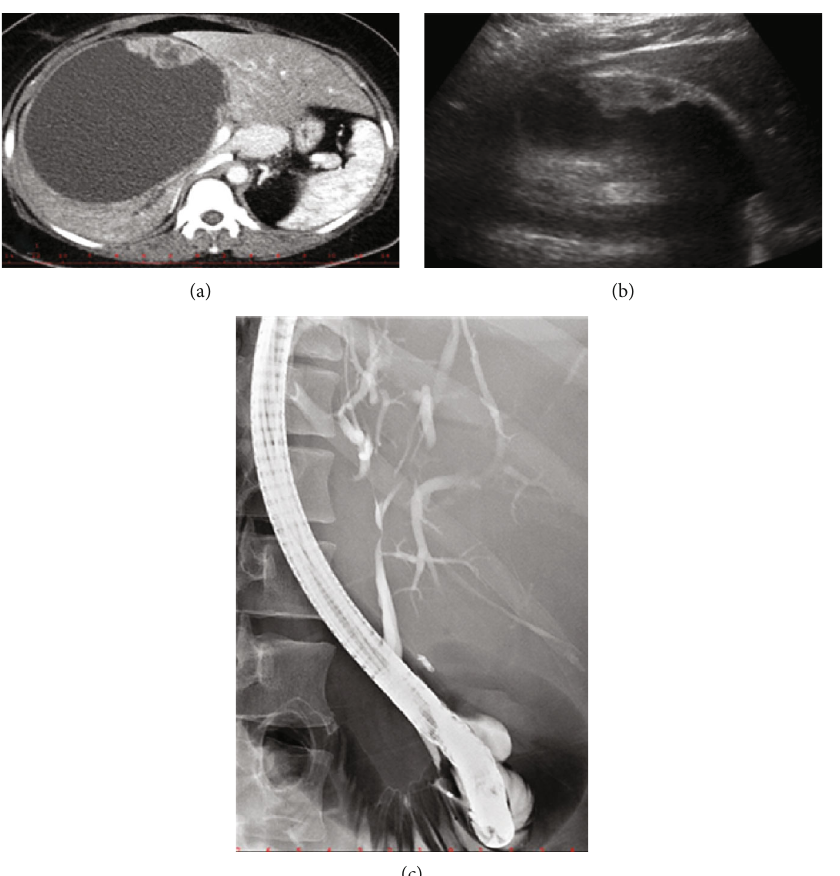
Figure 4: Imaging fi ndings in a patient with biliary mucinous cystic neoplasm. (a) CT image of a large BMCN in the right liver lobe with a hypodense solid component. (b) Ultrasound image of the same BMCN with a hypoechoic solid component by the wall. (c) ERCP image of the same patient showing s smooth stricture of the hepatic duct caused by extrinsic compression of the